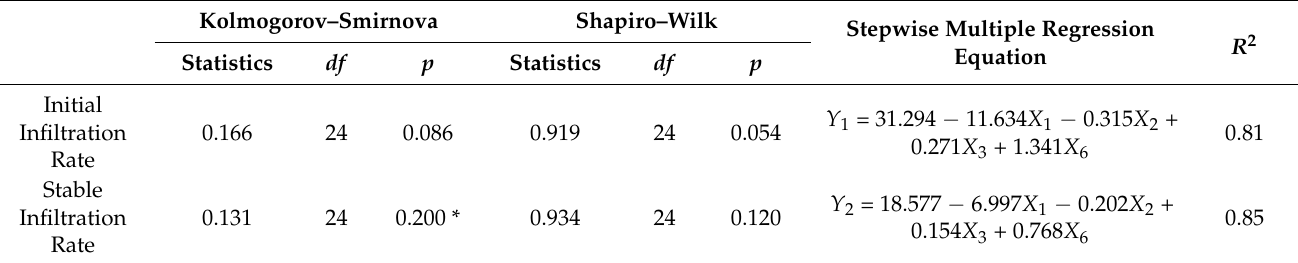
Table 5. Regression equation of infiltration rate and environmental